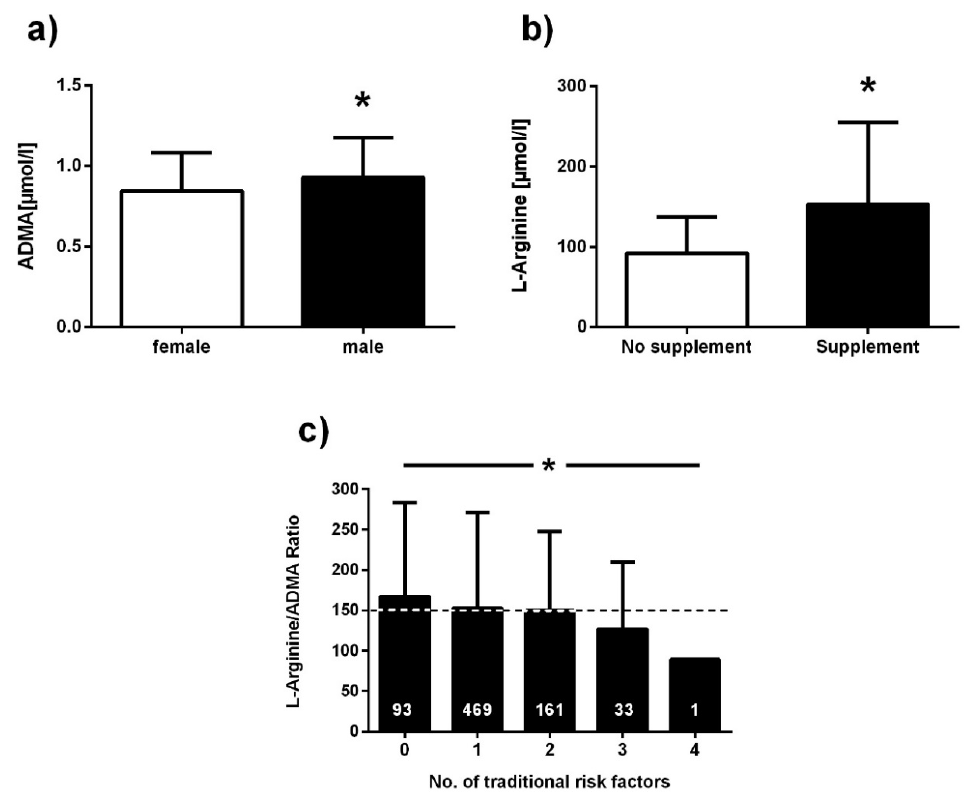
Figure 7. Clinical validation of dried blood spot ADMA and L-arginine. ( a ) ADMA concentration in dried blood spots in male and female subjects; ( b ) L-arginine concentration in dried blood spots in individuals taking L-arginine supplements or not; ( c ) L-arginine/ADMA ratio according to number of traditional risk factors present. Data are presented as mean ± SD; * p < 0.05 between groups in ( a ) and ( b ); * p < 0.05 for trend across risk factor groups in ( c ).